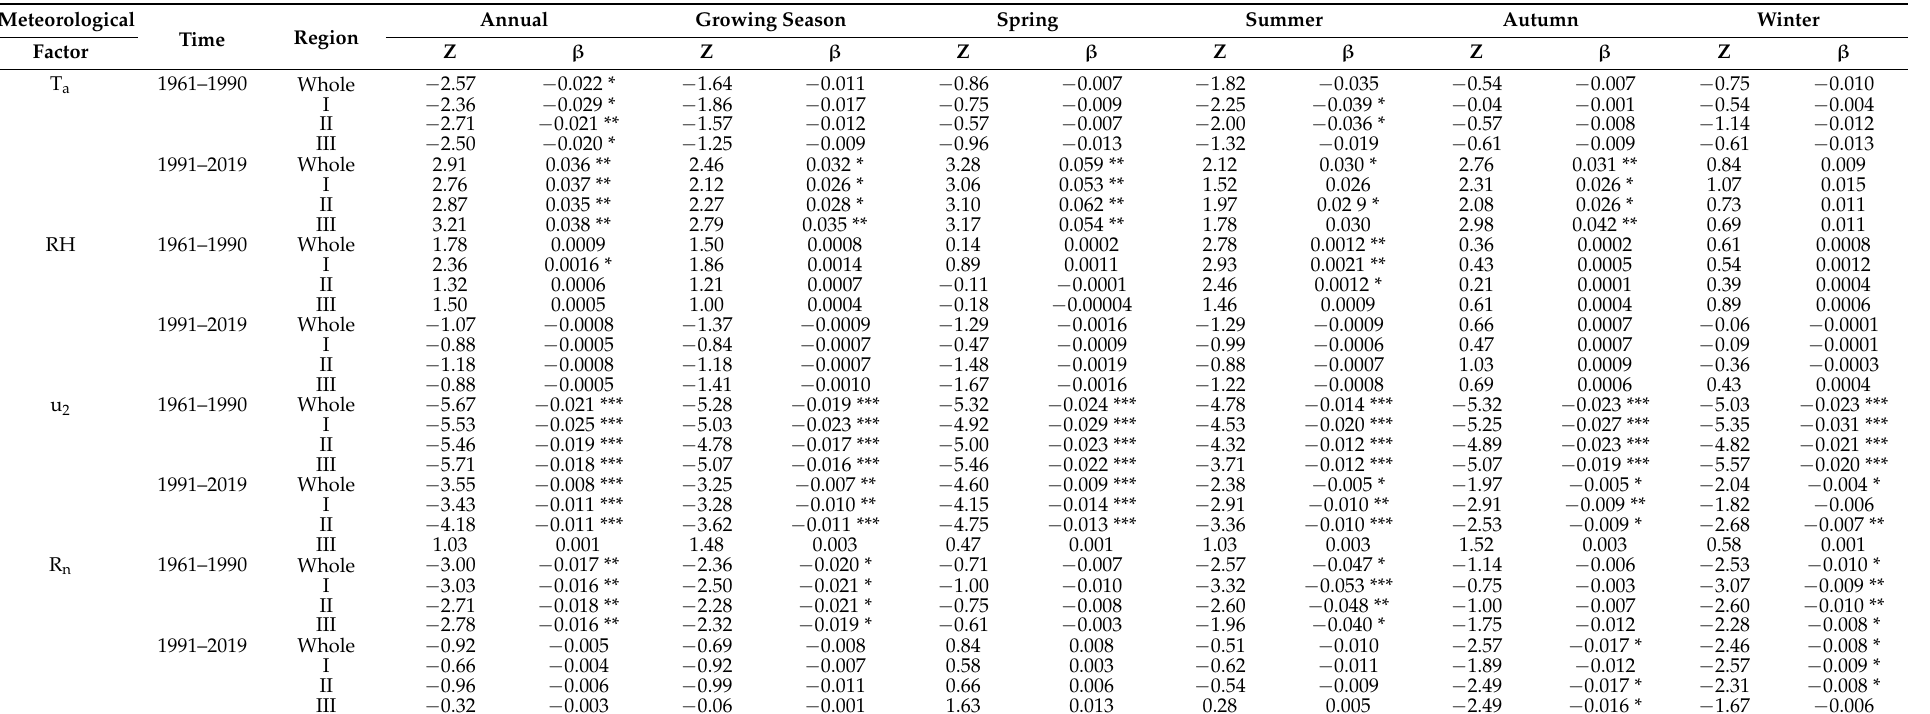
Table 2. Temporal trends of meteorological factors during 1961–1990 and 1991–2019 in Anhui